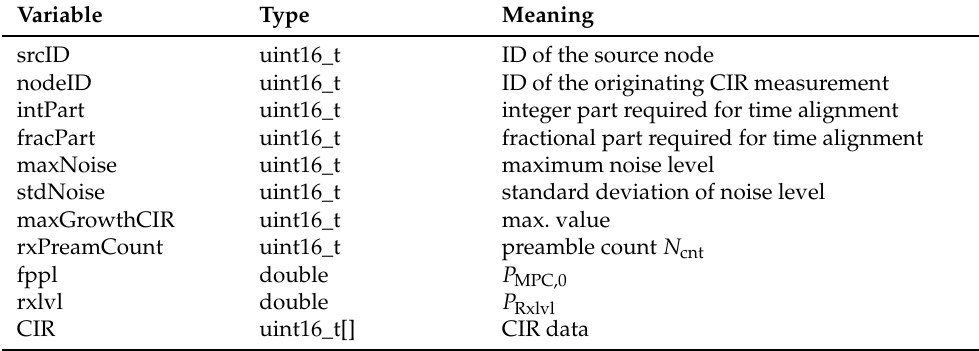
Table 1. CIR payload adapted from